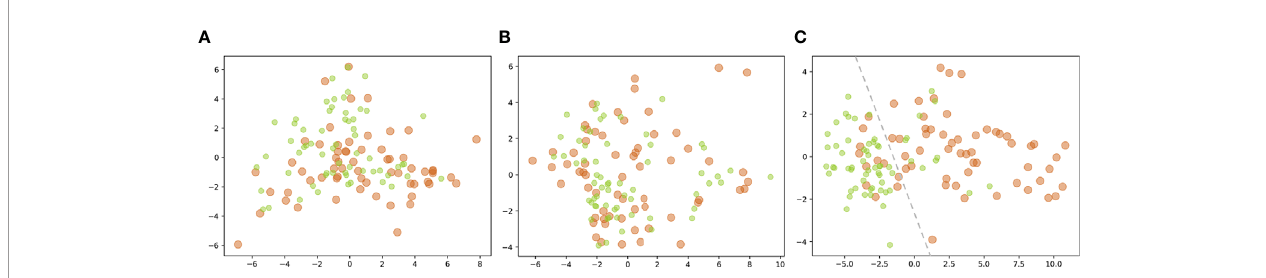
FIGURE 6 | Projection of the top 10 features [ (A) whole; (B) anterior; (C) posterior] of the pre- KN (green) and post- KN (orange) groups onto the two-dimensional scatter